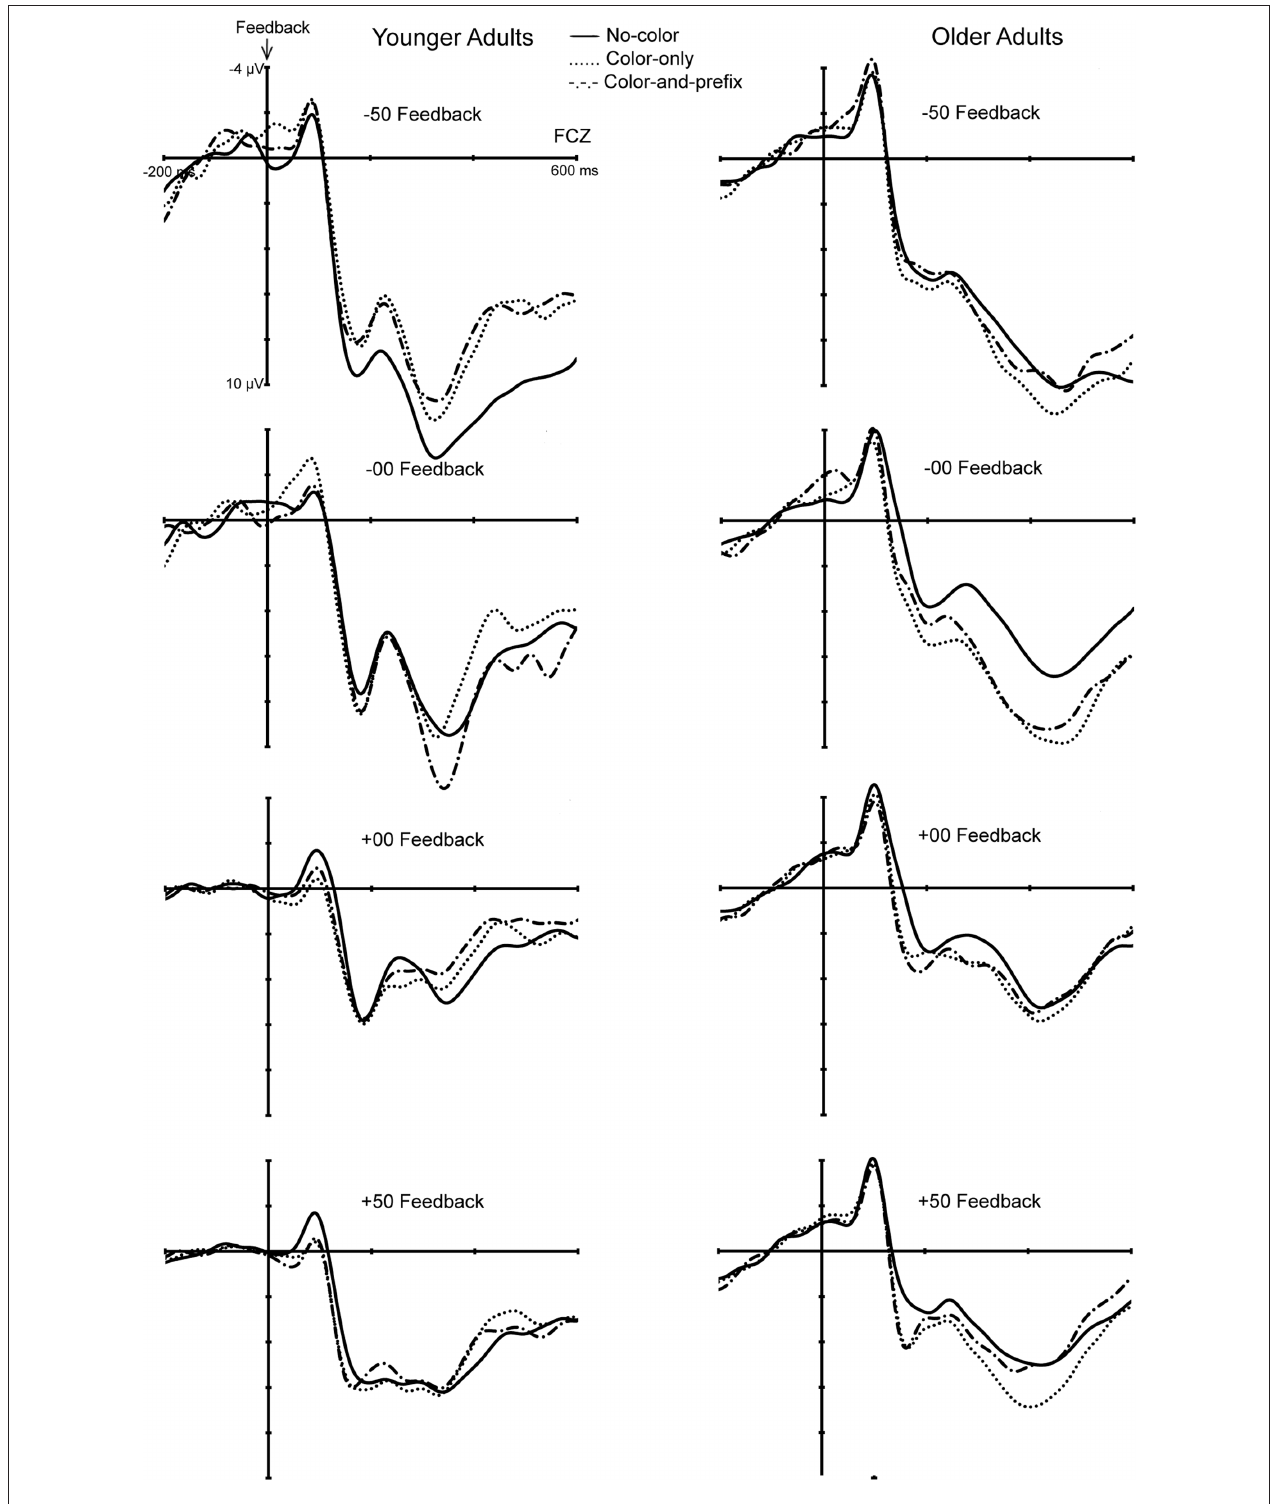
Figure 4 | Feedback‑locked erPs of the younger (left) and older (right) age groups for the four feedback types separately for the three feedback salience